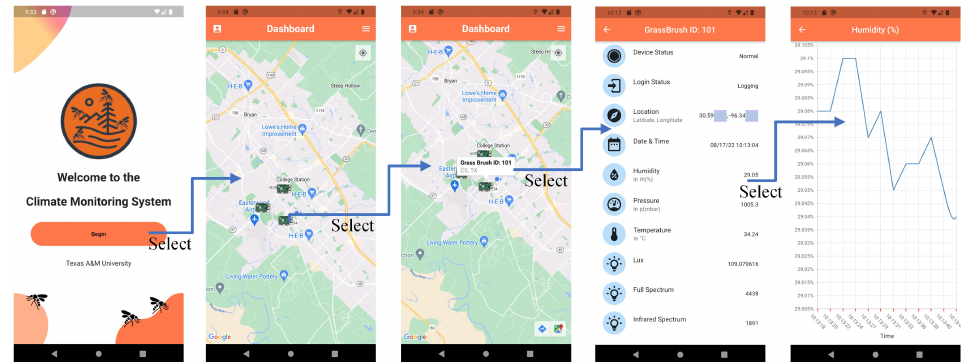
Figure 9. Data access over the Android application.